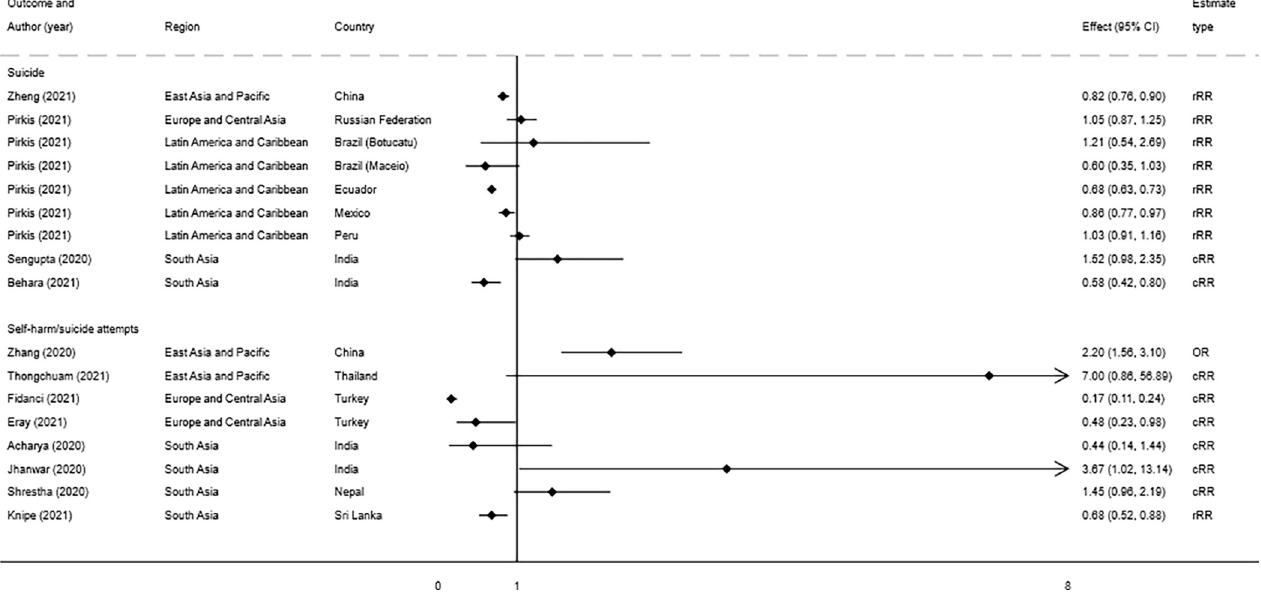
Fig 3. Forest plot of study estimates � assessing the impact of the pandemic on suicide deaths and self-harm from before and after or time-series studies. � An estimate of below 1 is indicative of a reduction in suicide or self harm. rRR–reported rate ratio; cRR–calculate rate ratio; OR–Odds